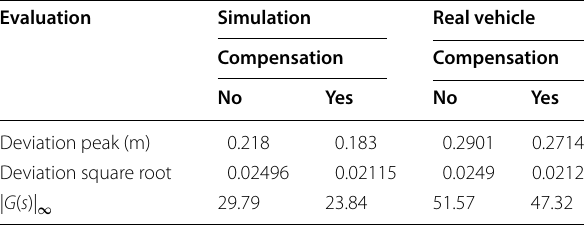
Table 6 Results of simulation experiment and real vehicle experiment